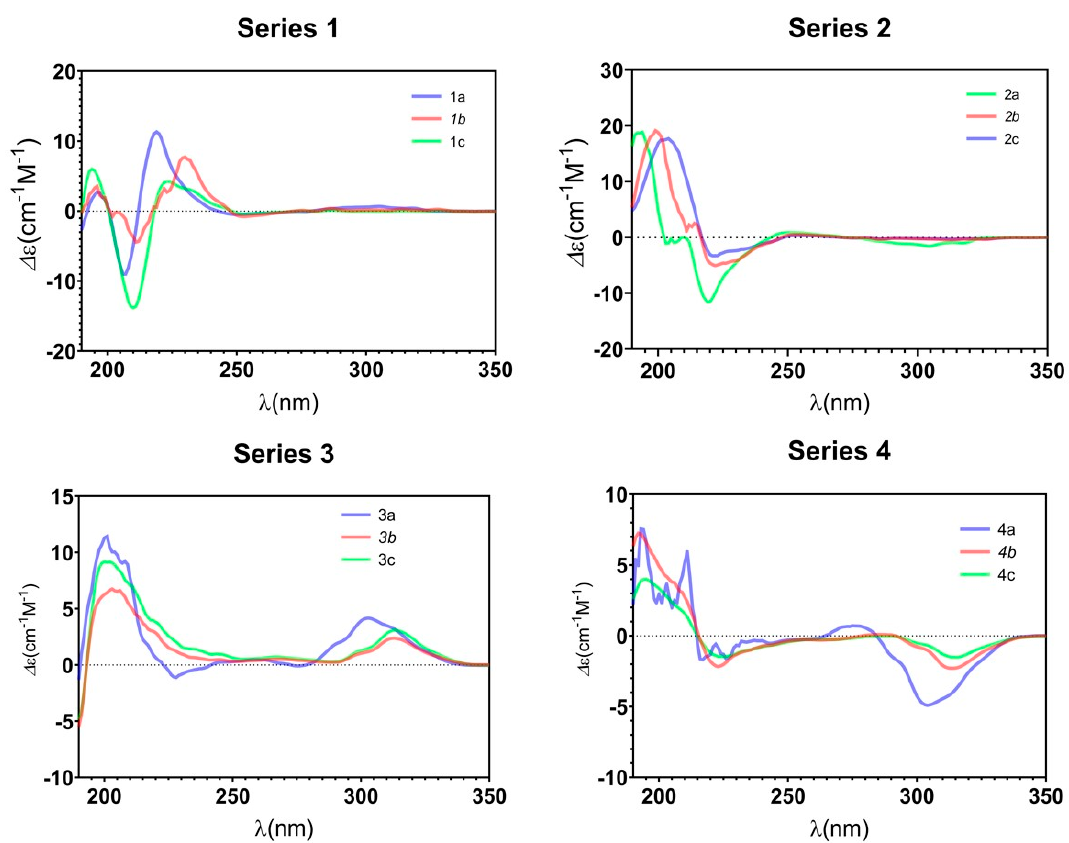
Figure 2. Experimental ECD spectra of compound series 1 – 4 .